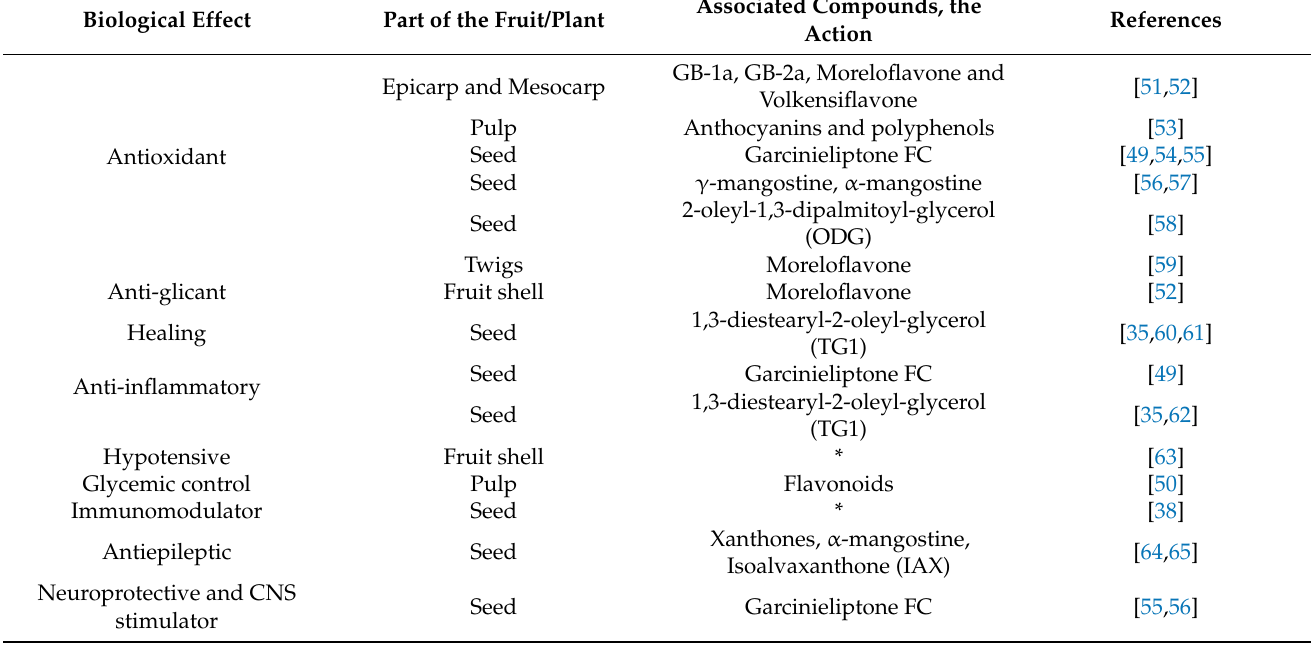
Table 7. Potential therapeutic use of the bacuri tree ( Platonia insignis